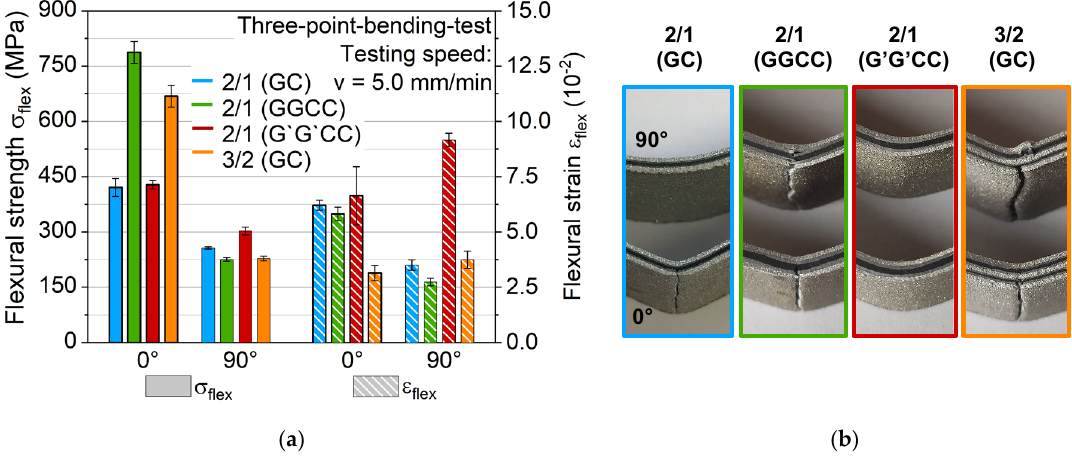
Figure 12. ( a ) Arithmetic flexural strength and strain values of hybrid laminates with aluminium alloy AA6082-T4 and a graded structure of glass and carbon fibre-reinforced PA6 for different layer structures and metal volume contents; ( b ) showing states of failure .